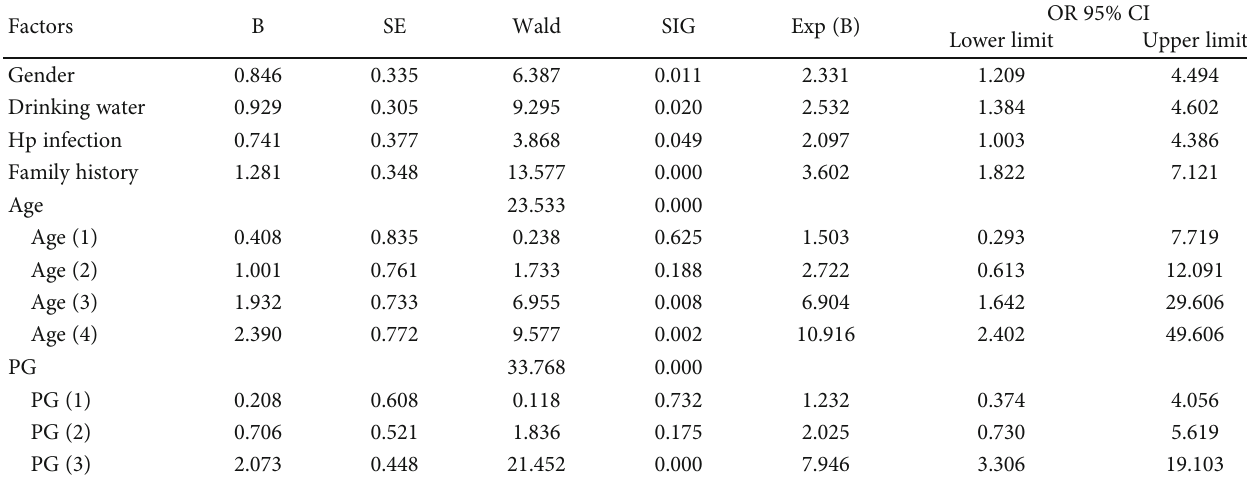
Table 4: Results of logistic regression